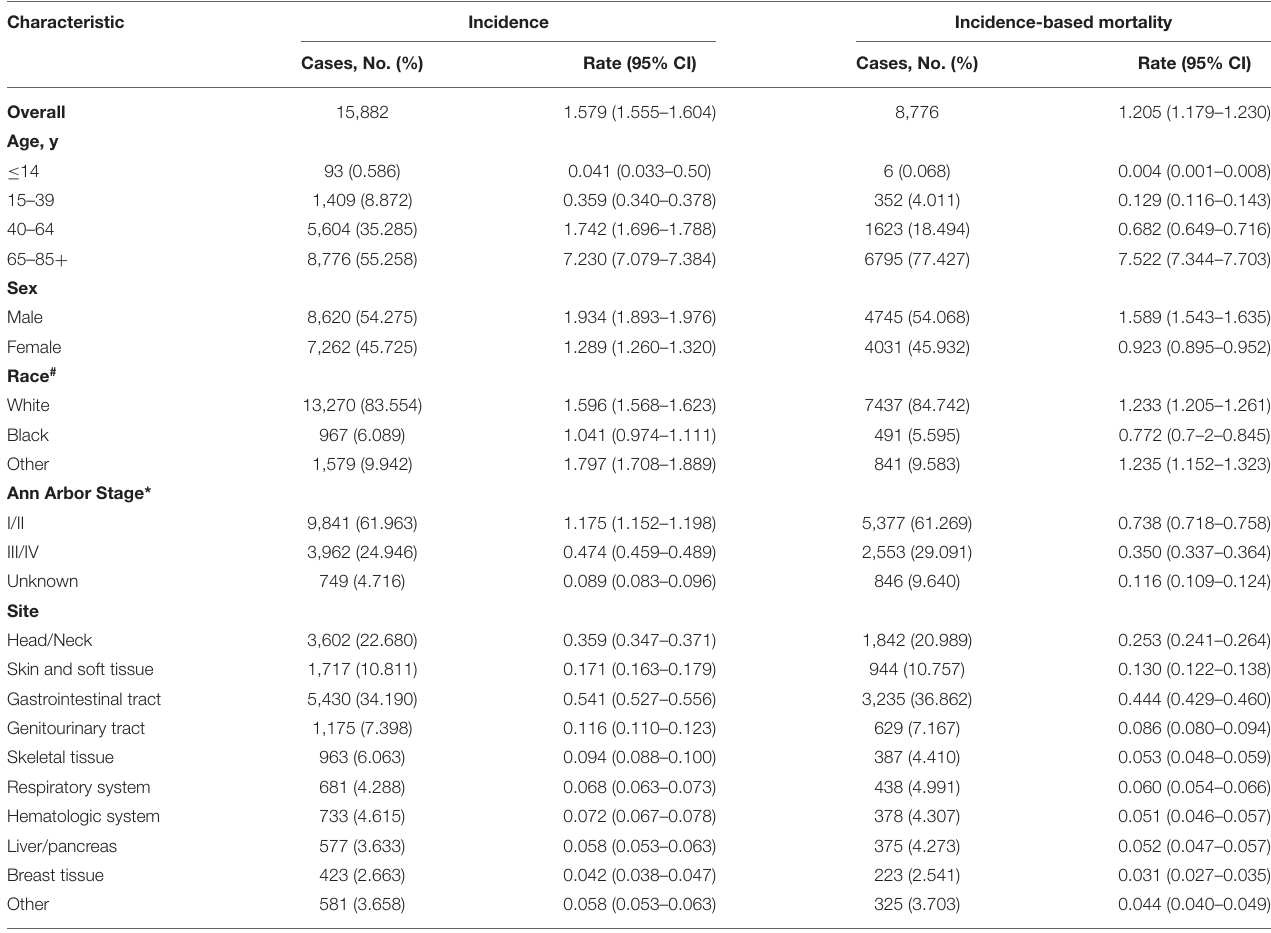
TABLE 1 | Extranodal diffuse large B-cell lymphoma incidence (1973–2015) and incidence-based mortality (1988–2015): the SEER-9 registry